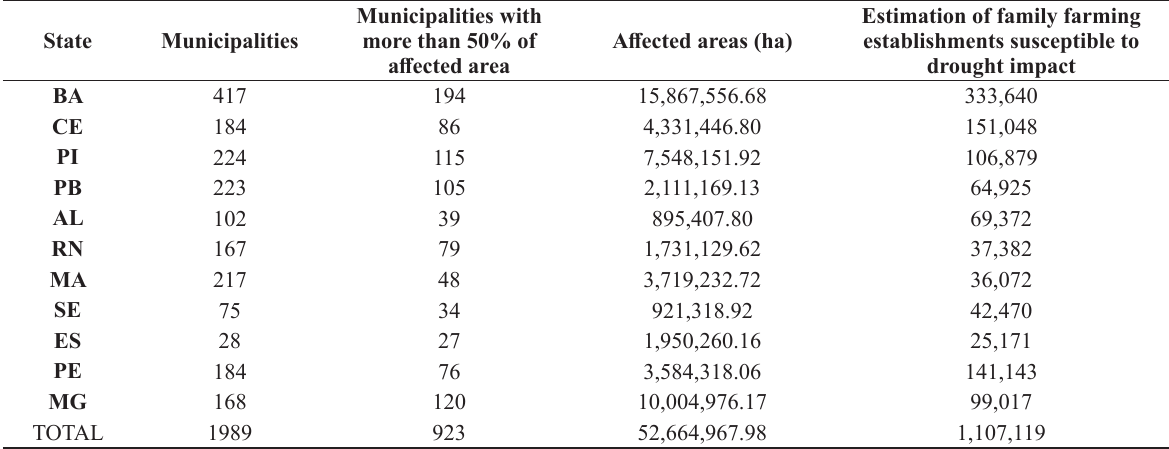
Impacts of drought in the municipalities related with SUDENE’s acting area from 2015 to 2016. Municipalities with Estimation of family farming State Municipalities more than 50% of Affected areas (ha) establishments susceptible to affected area drought